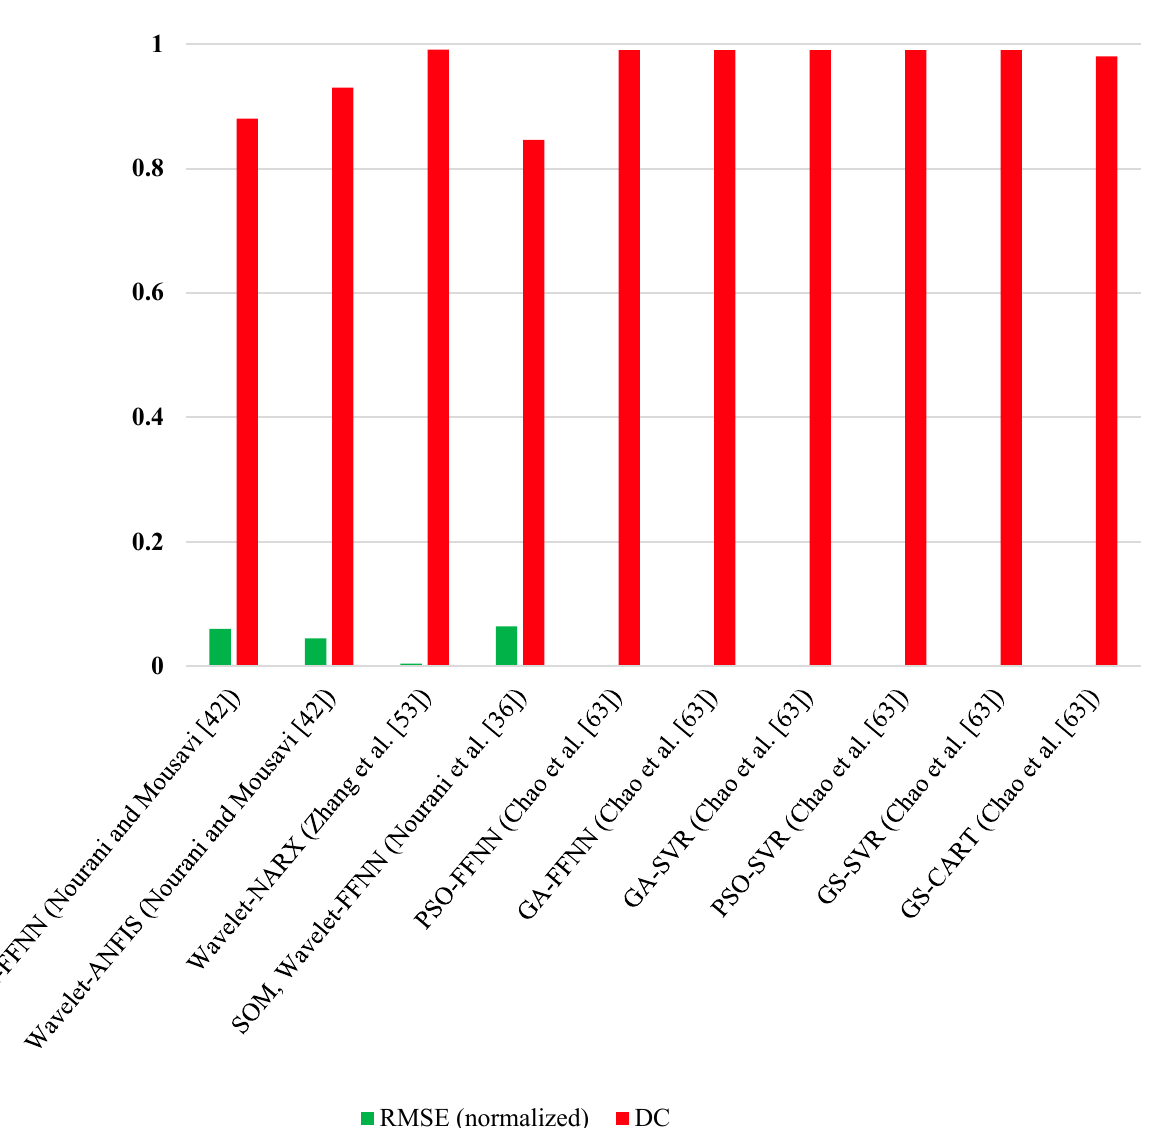
Figure 10. Comparative performance analysis of hybrid soft computing methods.